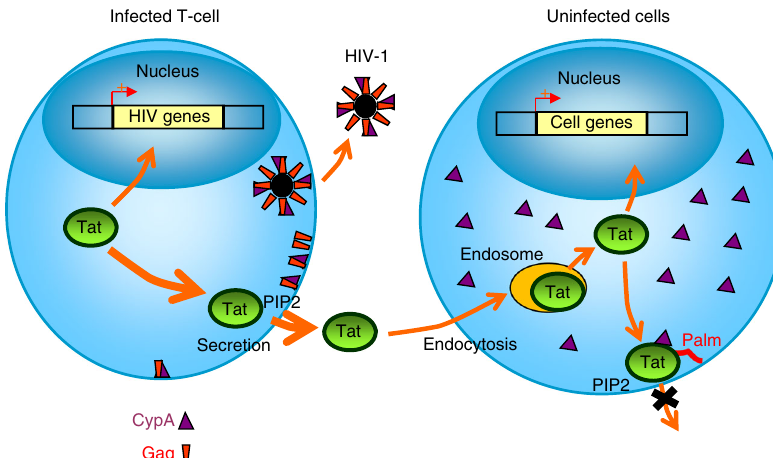
Fig. 10 Schematic representation of the results. Neosynthesized Tat enters the nucleus to ensure ef fi cient transcription of viral genes, but most (~60%) of Tat is secreted by infected cells using an unconventional mechanism based on the recruitment of Tat by PI(4,5)P 2 at the plasma membrane. Gag multimerization drives virus assembly at the plasma membrane. Because Gag binds CypA, virus budding depletes cells of CypA thereby inhibiting Tat palmitoylation speci fi cally and only in infected cells. Secreted Tat can enter target cells (such as macrophages, neurons, myocytes, etc) by endocytosis before translocation to the cytosol from endosomes. Tat can then go to the nucleus to affect the transcription of cellular genes, but most of it is recruited by PI(4,5)P 2 at the plasma membrane, before CypA-dependent palmitoylation. Tat palmitoylation inhibits its secretion and enables cumulative effects of minute Tat doses that will ef fi ciently impair PI(4,5)P 2 -dependent cell activities such as, depending on cell types, phagocytosis, neurosecretion and ion transport (not